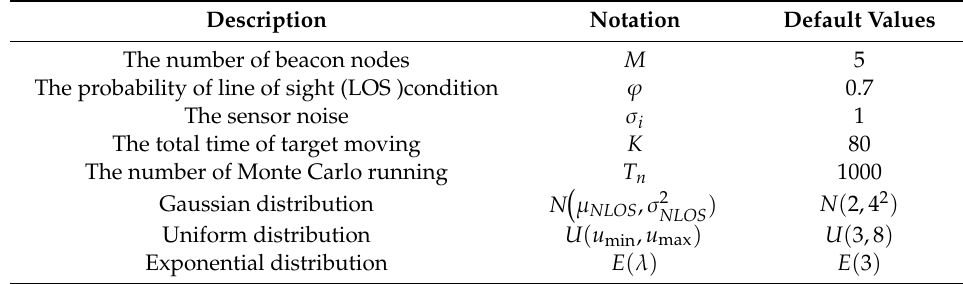
Figure 4. The trajectory and the position of beacon nodes in one Monte Carlo run. The default parameters’ values under di ff erent NLOS distributions are shown as Table 2.